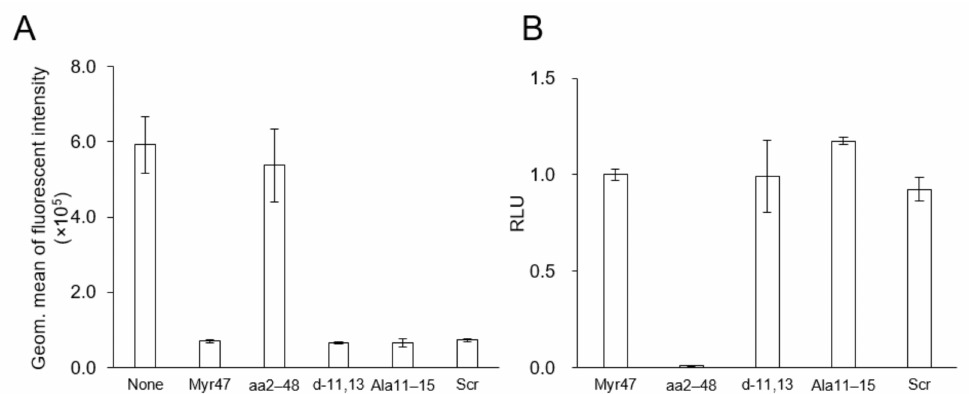
Figure 4. Effect of Myr47 and its mutants on the cellular LP uptake activity and the in vitro direct interaction with LPs. ( A ) Hep G2 cells were incubated with DiD-LPs (5 µ g/mL) in serum-free DMEM containing Myr47 or its mutants (500 nM) for 3 h at 37 ◦ C and then analyzed with flow cytometry. ( B ) Interaction of Myr47 or its mutants with LPs analyzed by AlphaScreen assay. Data are shown as means ± S.D. ( n =